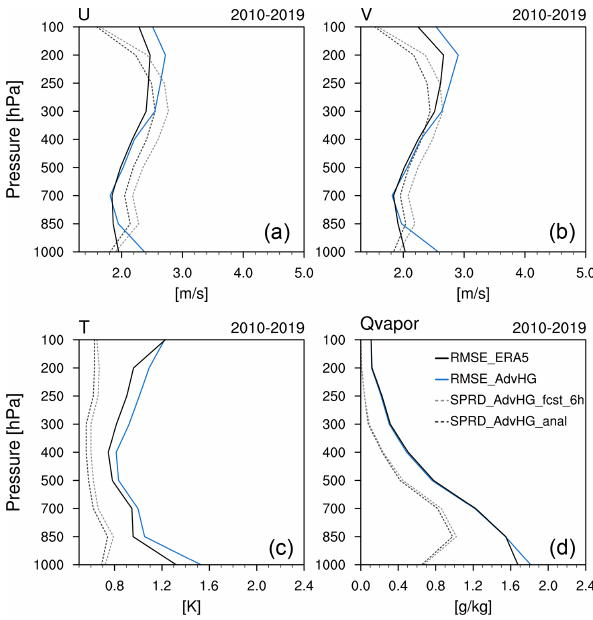
Figure 6. RMSEs of analysis of (a) zonal wind, (b) meridional wind, (c) temperature, and (d) Qvapor (water vapor mixing ratio) from ERA5 (solid black line) and AdvHG (solid blue line) and spreads of analysis (dashed black line) and 6h forecast (dashed gray line) of AdvHG depending on pressure levels averaged over the 10- year period